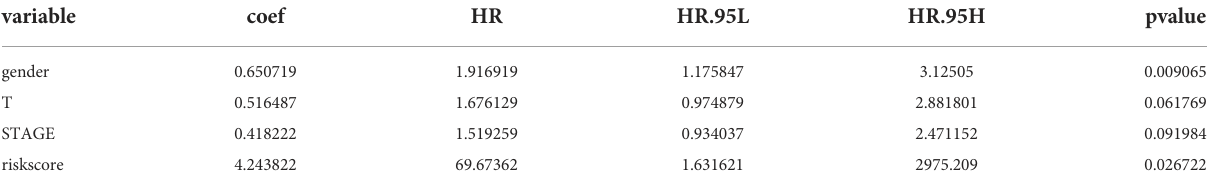
TABLE 7 Independent prognostic indicators of LUAD were detected by multivariate Cox regression analysis in the TCGA-LUAD cohort. variable